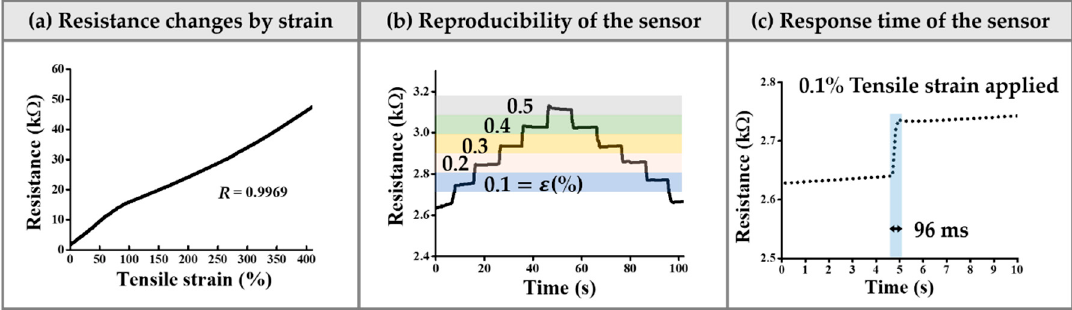
Figure 5. Sensing properties of the strain sensor. (a) Changes in electrical resistance for 0% to 450% tensile strain (R = 0.9969). (b) Resistance of the strain sensor with 0.1% step-keep changes in strain. (c) ( b ) Resistance of the strain sensor with 0.1% step-keep changes in strain. ( c ) Sensor response time at 0.1% tensile Sensor response time at 0.1% tensile strain.